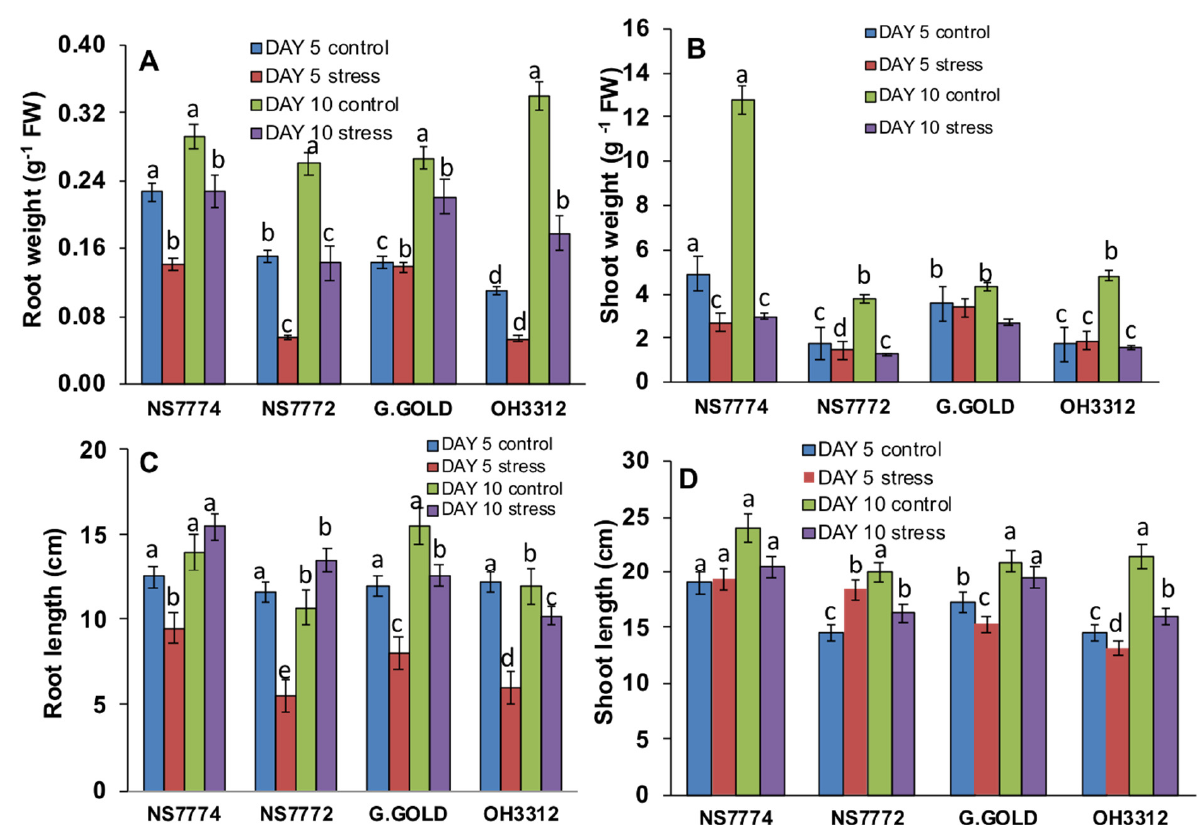
Figure 2. Changes in ( A ) root weight, ( B ) shoot weight, ( C ) root length, and ( D ) shoot length, as affected by drought stress at 5 and 10 days of interval in okra genotypes NS7774, NS7772, Green Gold and OH 3312 as along with their controls. Vertical bars indicate mean ± SE for n = 5. Means denoted by a different letter are significantly different at p ≤ 0.05 according to the Tukey’s studentized range test.